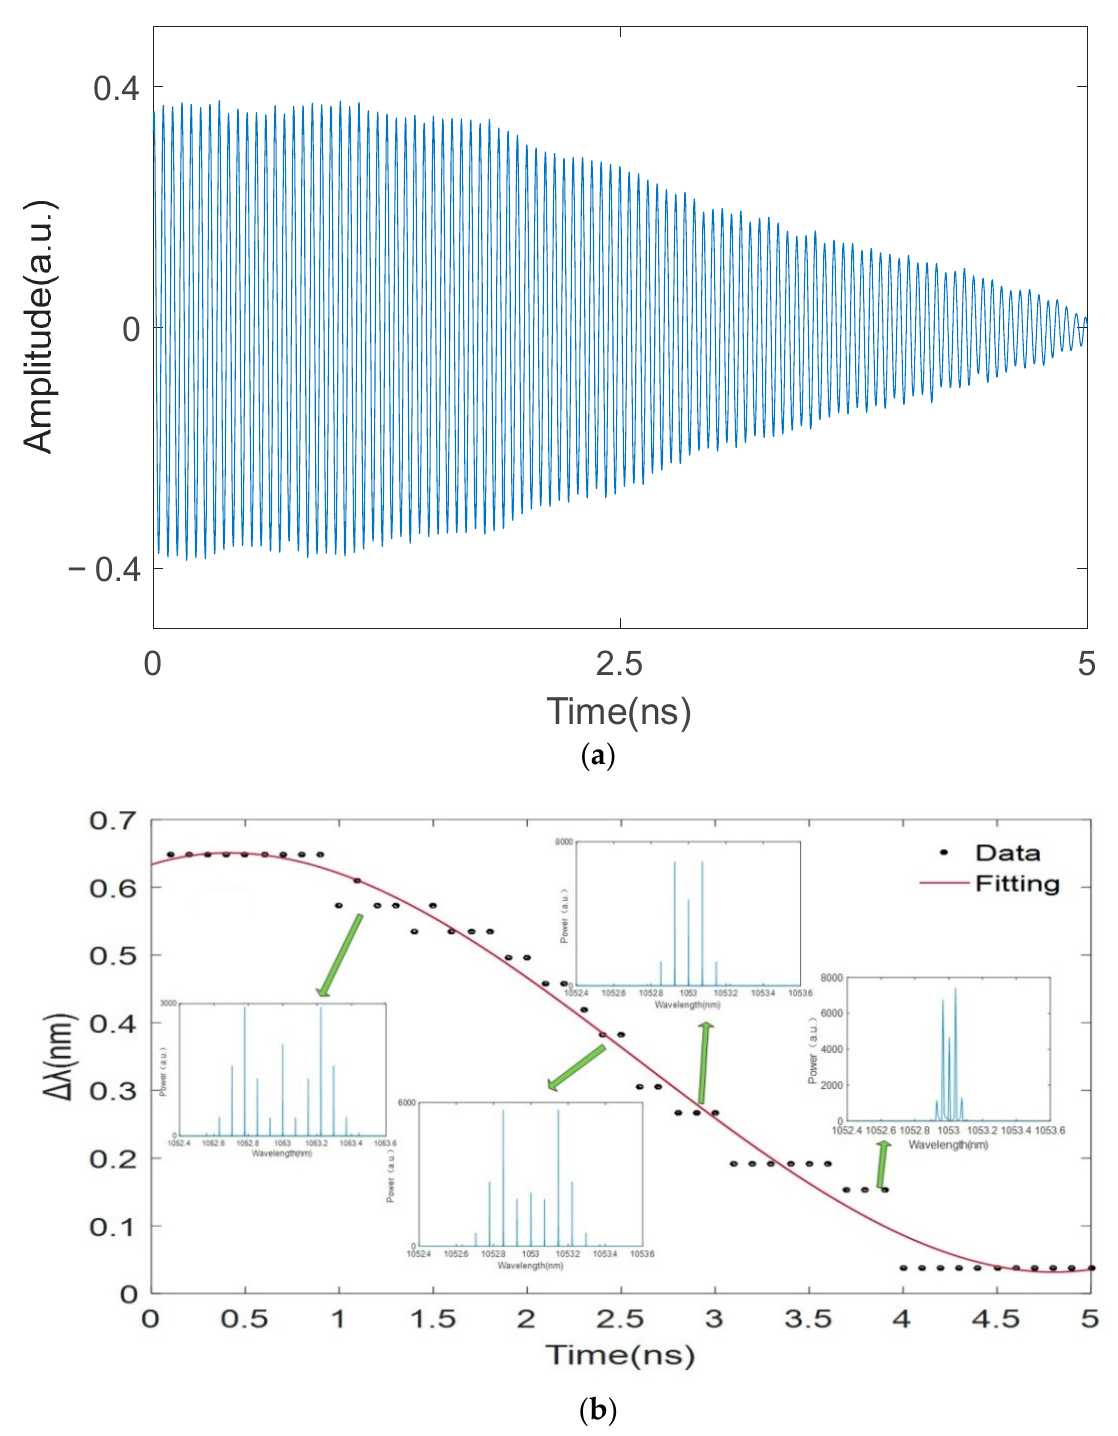
Figure 2. Simulations results of the spectral phase modulation with dynamic width: ( a ) specific modulation function. ( b ) Change of spectral width with time.